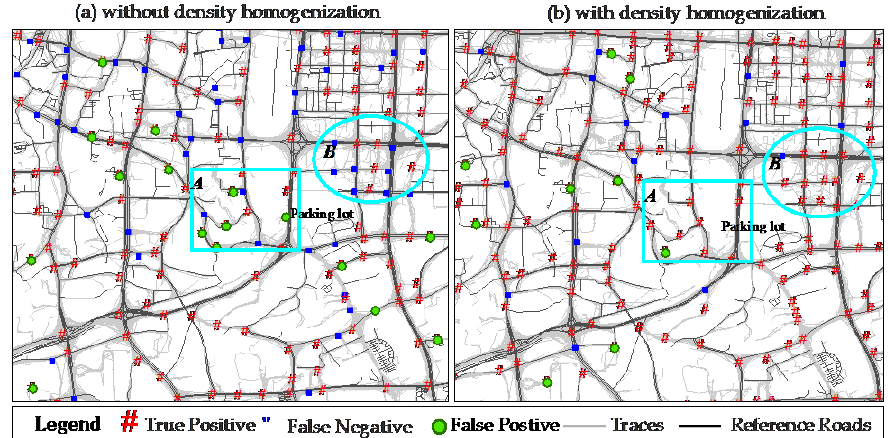
Figure 9. Comparison of road intersections detection without/with density homogenization. ( a ) with- out density homogenization, ( b ) with density